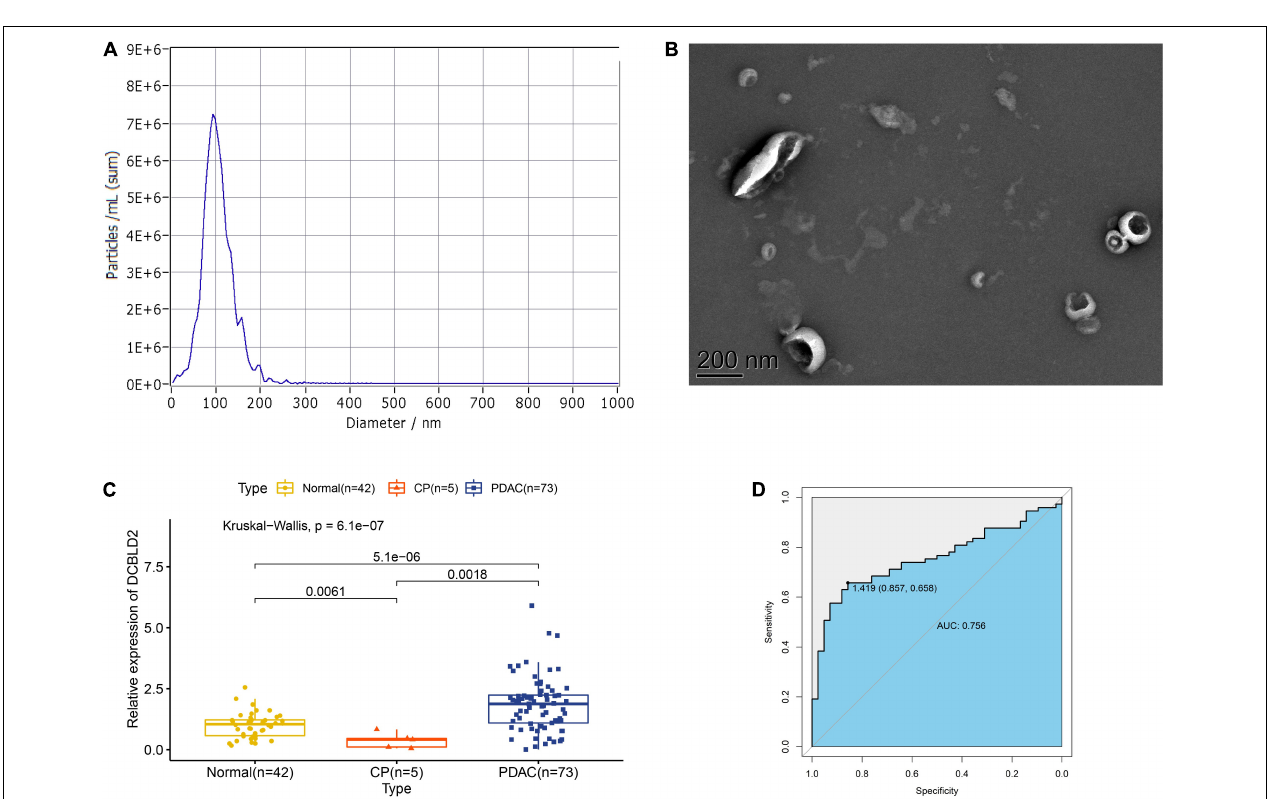
FIGURE 8 | Expression of DCBLD2 in extracellular vesicles from human plasma samples. (A) Boxplots show the distribution of extracellular vesicular DCBLD2 expression in plasma samples from healthy donors, CP patients and PDAC patients. (B) ROC curve showed the diagnostic value of extracellular vesicular DCBLD2 (PDAC vs Normal + CP). The statistical significance in comparing DCBLD2 expression between the two groups was determined by Wilcoxon test.